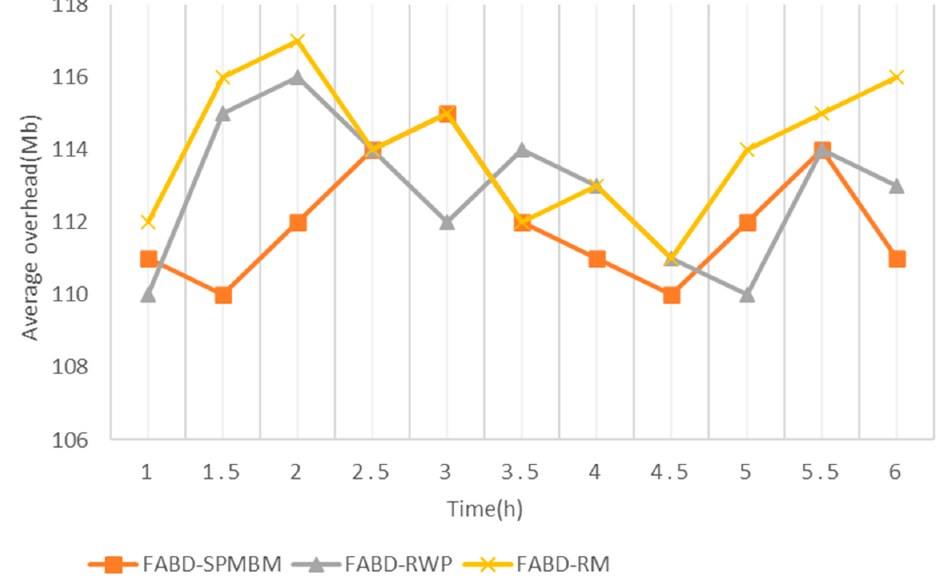
Figure 13. the routing cost of the FABD algorithm under the three mobility models. Figure 13. The routing cost of the FABD algorithm under the three mobility